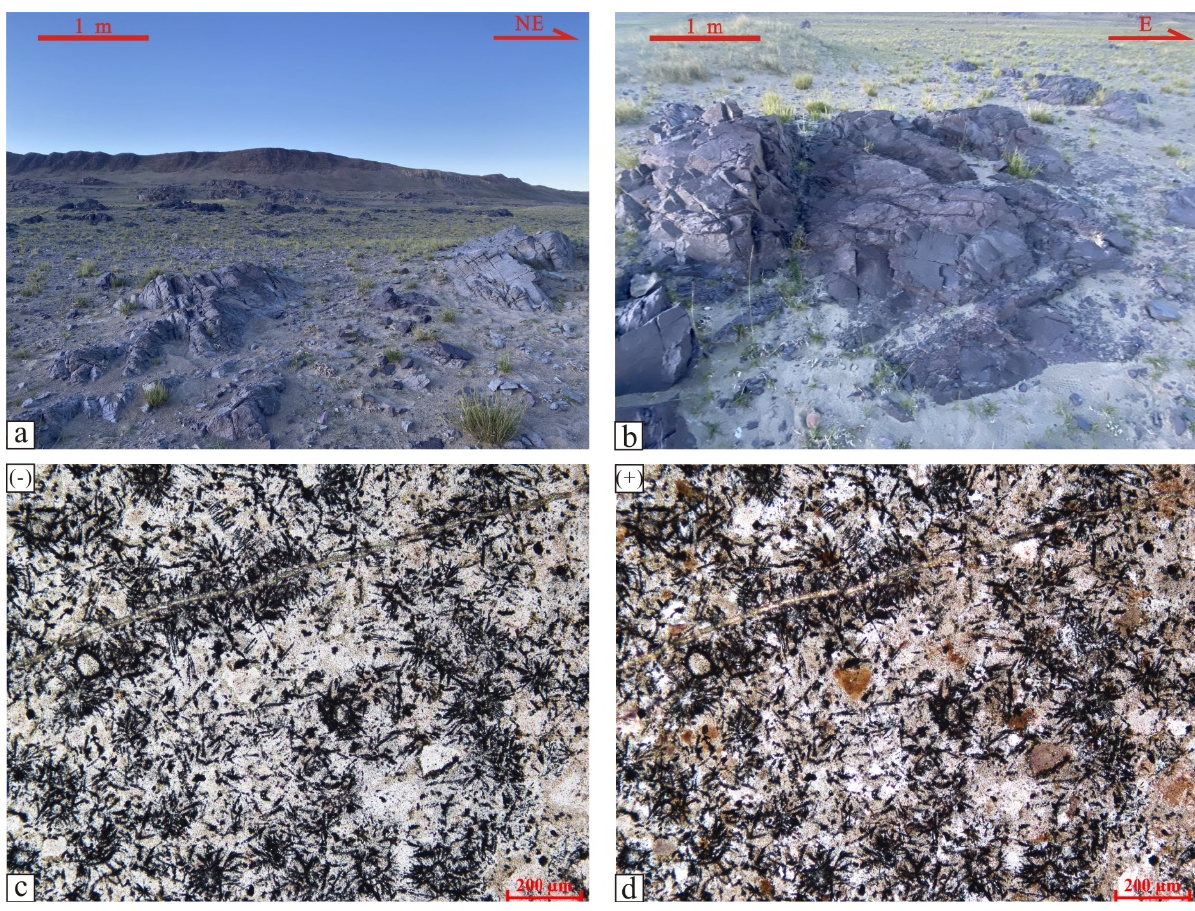
Figure 2. Field outcrops and microscopic mineral photos of volcanic rock in the Jingzhushan For- mation from Coqen Basin. ( a – d